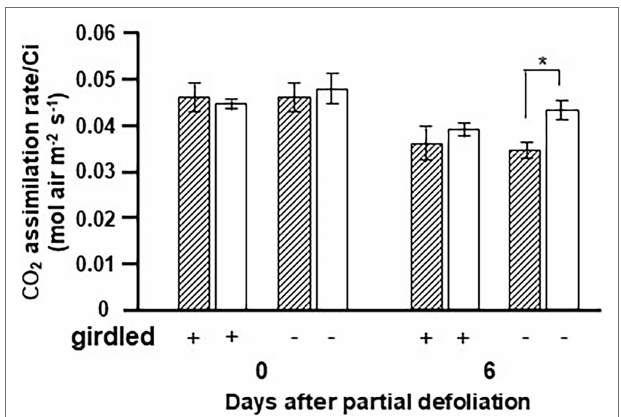
FIGURE 5 | Effect of girdling on the photosynthetic activity response to partial defoliation. Photosynthetic rate per internal CO 2 concentration (Ci) of source leaves in nondefoliated plants (hatched bars) and the remaining tomato leaves after partial defoliation of the other leaves (empty bars). Defoliation was performed on mature variety M82 plants at the reproductive stage. Lower stem girdling was performed immediately after partial defoliation. Plants were grown in a temperature-controlled greenhouse (25 ° C/18 ° C day/night). Data represent means (±SE) of five biological replicates. Asterisks indicate significant differences between partially defoliated and nondefoliated plants at p < 0.05 by Student’s t